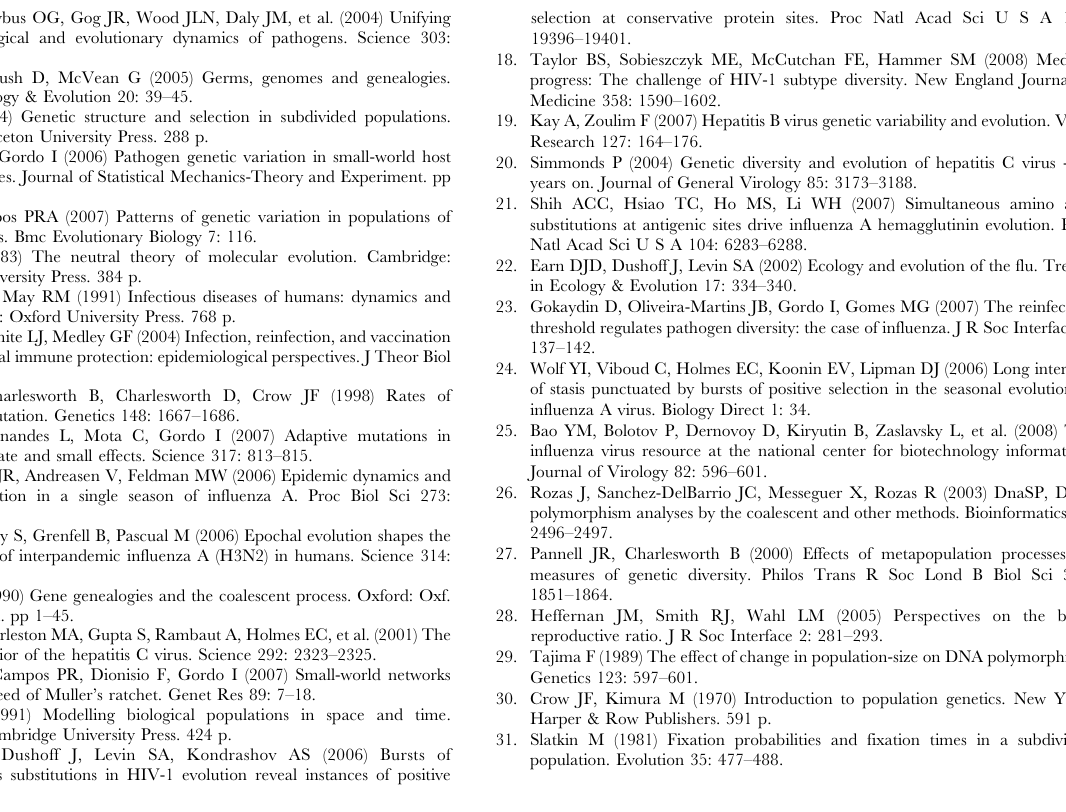
of hosts infected with new selected strain (filled line). Parameters